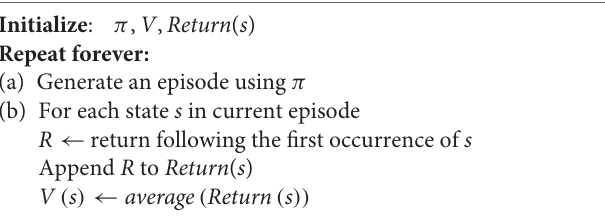
Algorithm 1. Monte Carlo policy